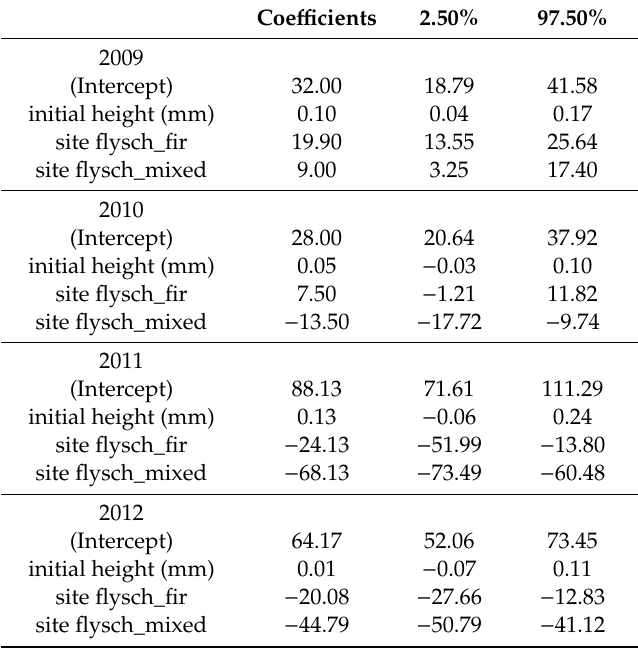
Table 5. Parameters and confidence intervals for quantile regression models of apical growth (mm), tau = 0.5. Correlation coe ffi cients for site groups concern di ff erences with group